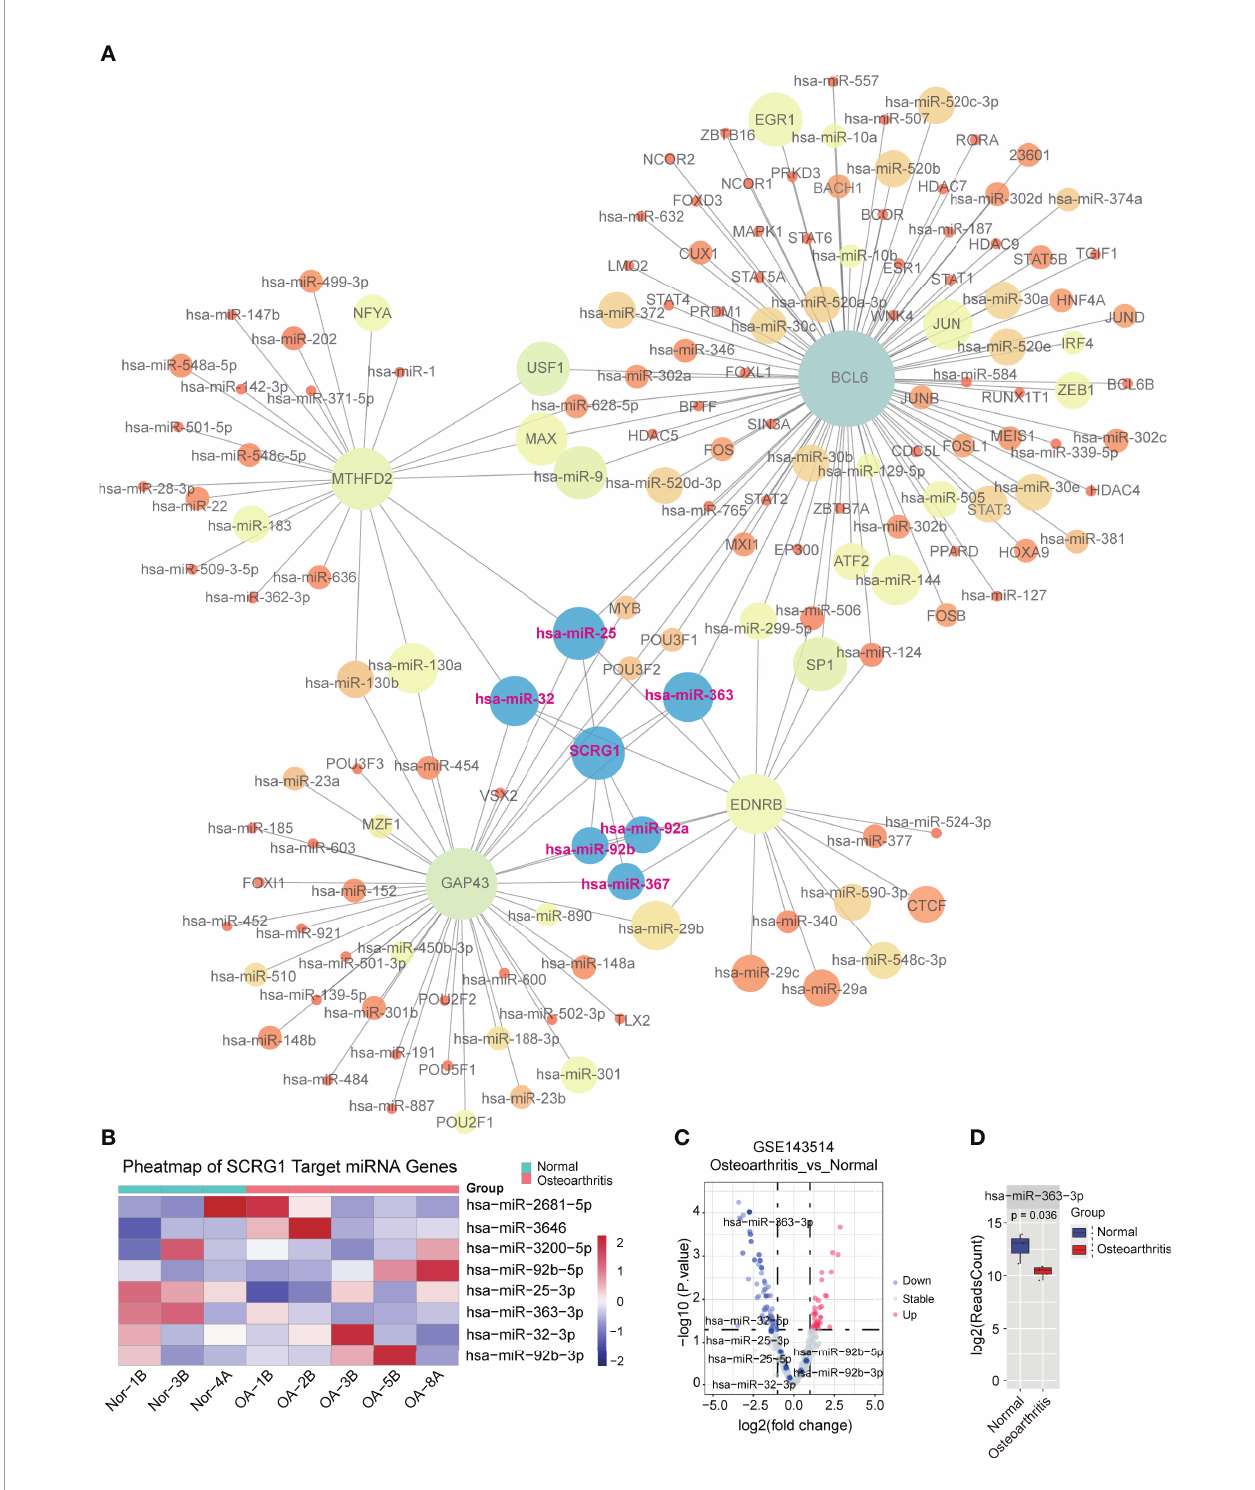
FIGURE 5 | TF-miRNA co-regulatory network of 27 genes associated with SCRG1. (A) The TF-miRNA co-regulatory network for 27 genes, SCRG1 was not found as the corresponding transcript factor in network, but 6 miRNAs can regulate SCRG1 gene expression. (B,C) volcano and heatmap plot of the miRNA expression in GSE143514 dataset, which represents the differential expression of values in synovium and normal tissues. Red color dot in Volcano plot represents up-regulated expression in synovium tissue. (D) hsa-miRA-363-3p was signi fi cantly differentially expressed in synovium